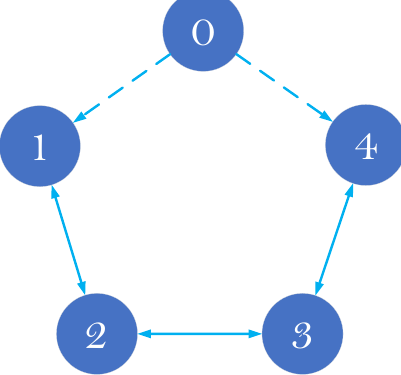
Figure 2. Communication